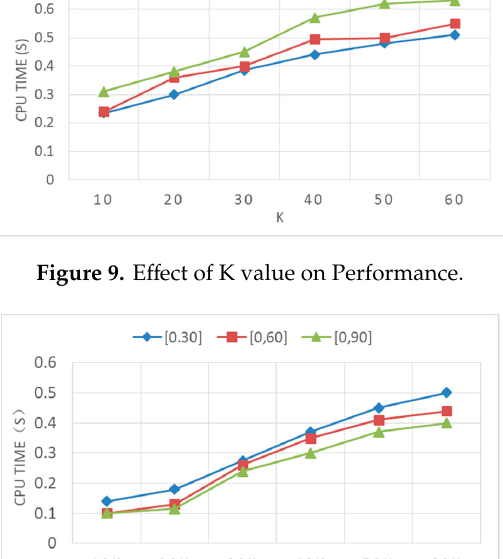
Figure 11. Effect of K value on Performance.